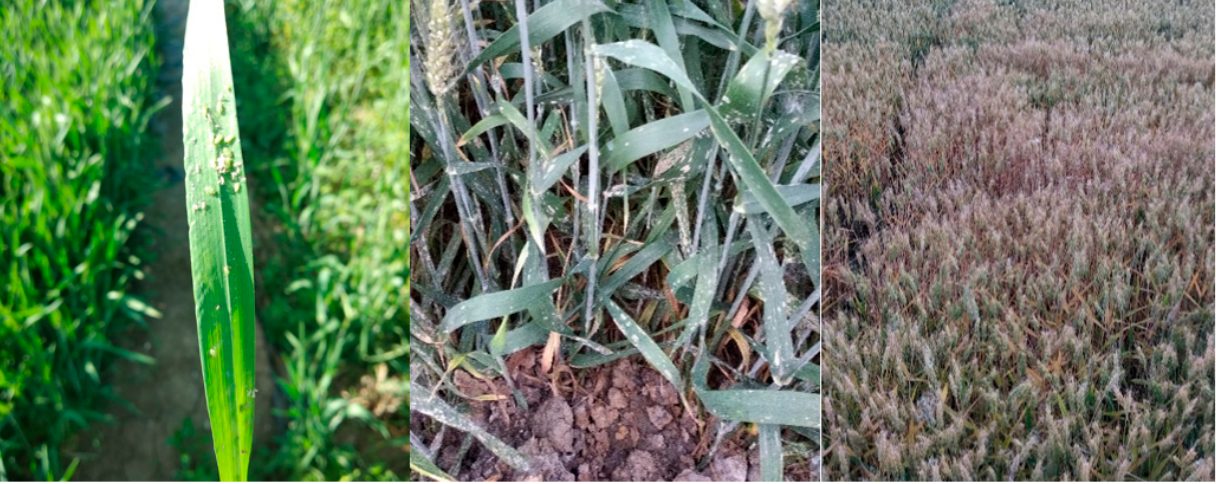
Figure 7. Wheat aphids, powdery mildew, and head blight occurrence in the test